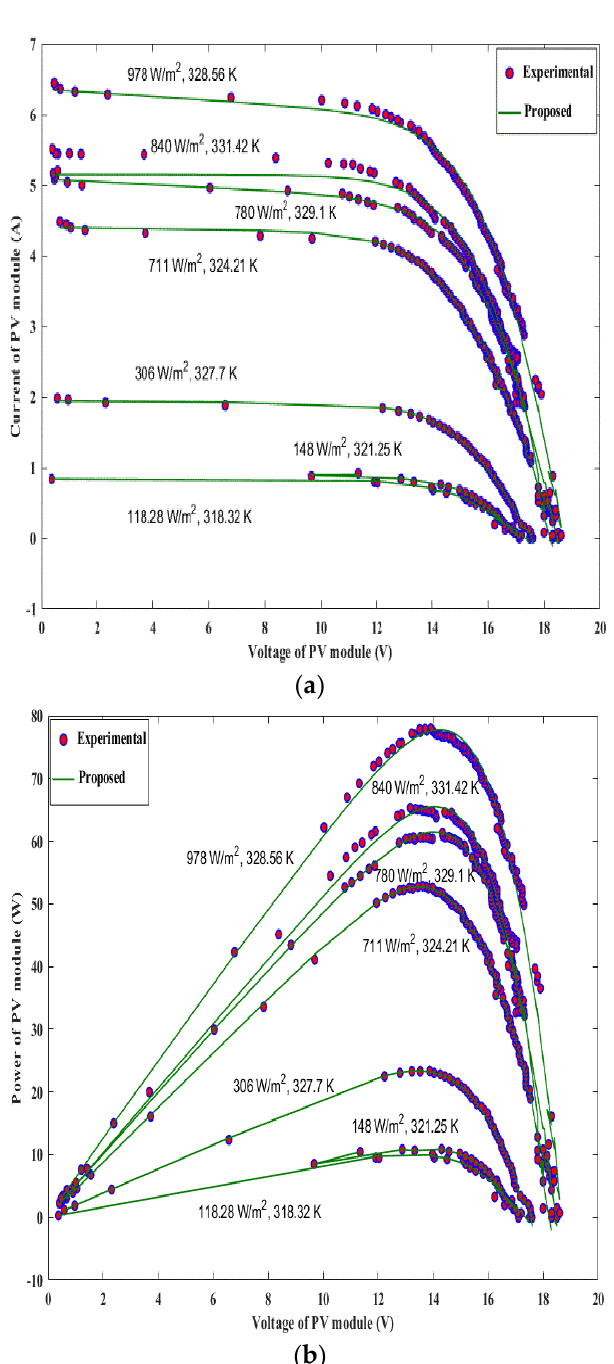
Figure 3. PV curves at different weather conditions of the improved electromagnetism-like (IEM) algorithm: ( a ) I – V curves and ( b ) P – V curves.